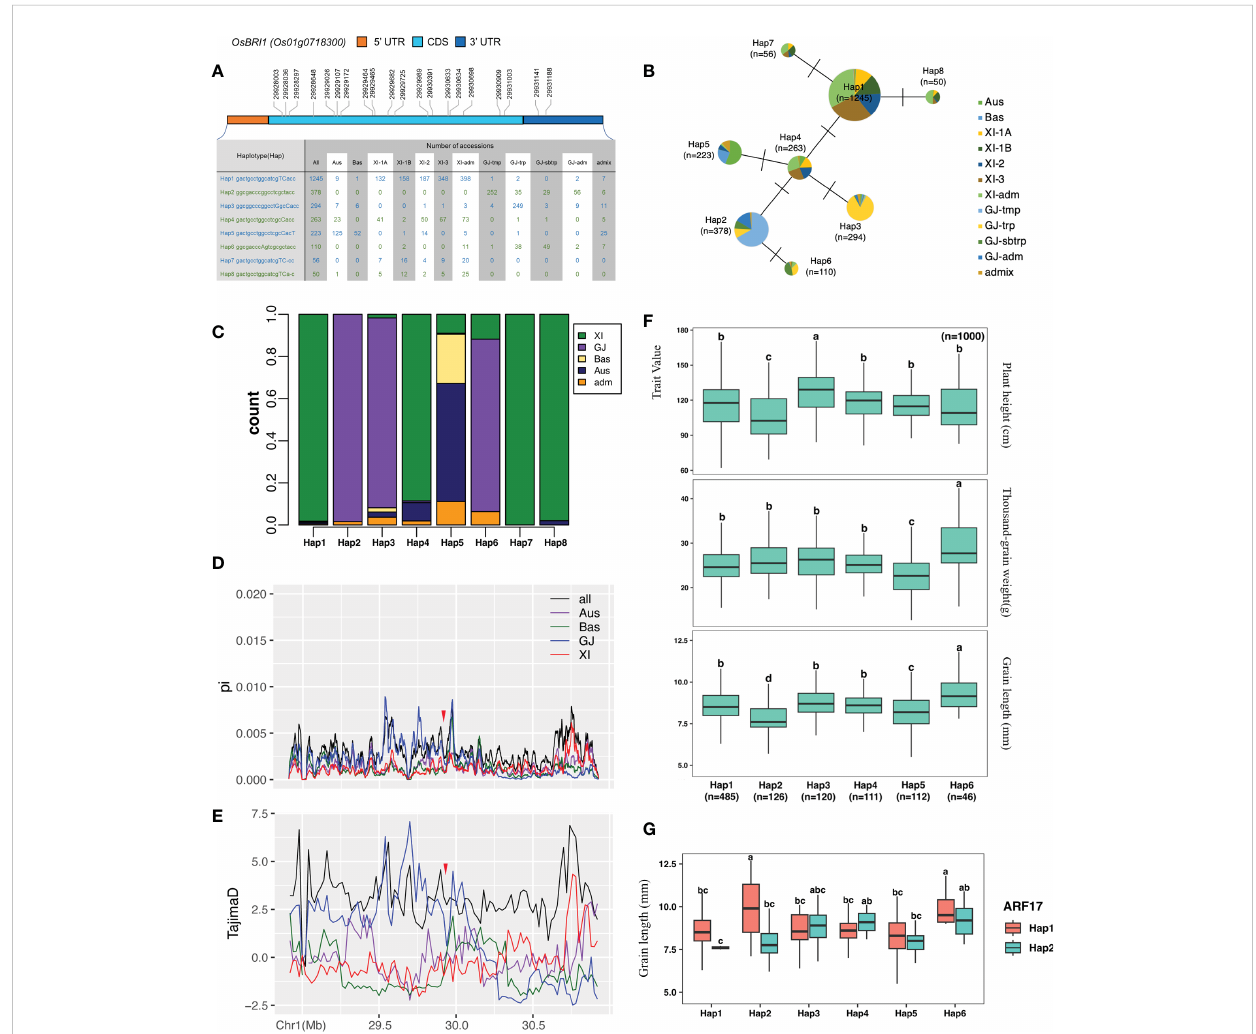
FIGURE 6 Haplotype analysis of HFR131 and OsARF17 . (A) Haplotypes of HFR131 / OsBRI1 . An uppercase letter in the haplotype sequence indicates a nonsynonymous mutation compared with Hap2. (B) Evolutionary network of HFR131 haplotypes. (C) Frequency of HFR131 haplotypes among subgroups of rice accessions. (D, E) Nucleotide diversity ( p ) and Tajima ’ s D for ∼ 1 Mb genomic region fl anking HFR131 . The red arrow indicates the position of HFR131 . (F) Distribution of plant height, grain length, and thousand-grain weight among rice accessions with different HFR131 haplotypes. (G) Grain length of rice accessions with different haplotypes of HFR131 and OsARF17 Aus , Bas , XI , and GJ refer to different subgroups of rice and Adm ( admix ) is a fully mixed group. XI-1A , XI-1B , XI-2 , XI-3 , and XI-adm belong to the XI group. GJ-tmp , GJ-trp , GJ-sbtrp , and GJ-adm belong to the GJ group. Different letters on the boxplots indicate statistically signi fi cant differences at P < 0.05 based on Duncan ’ s multiple range